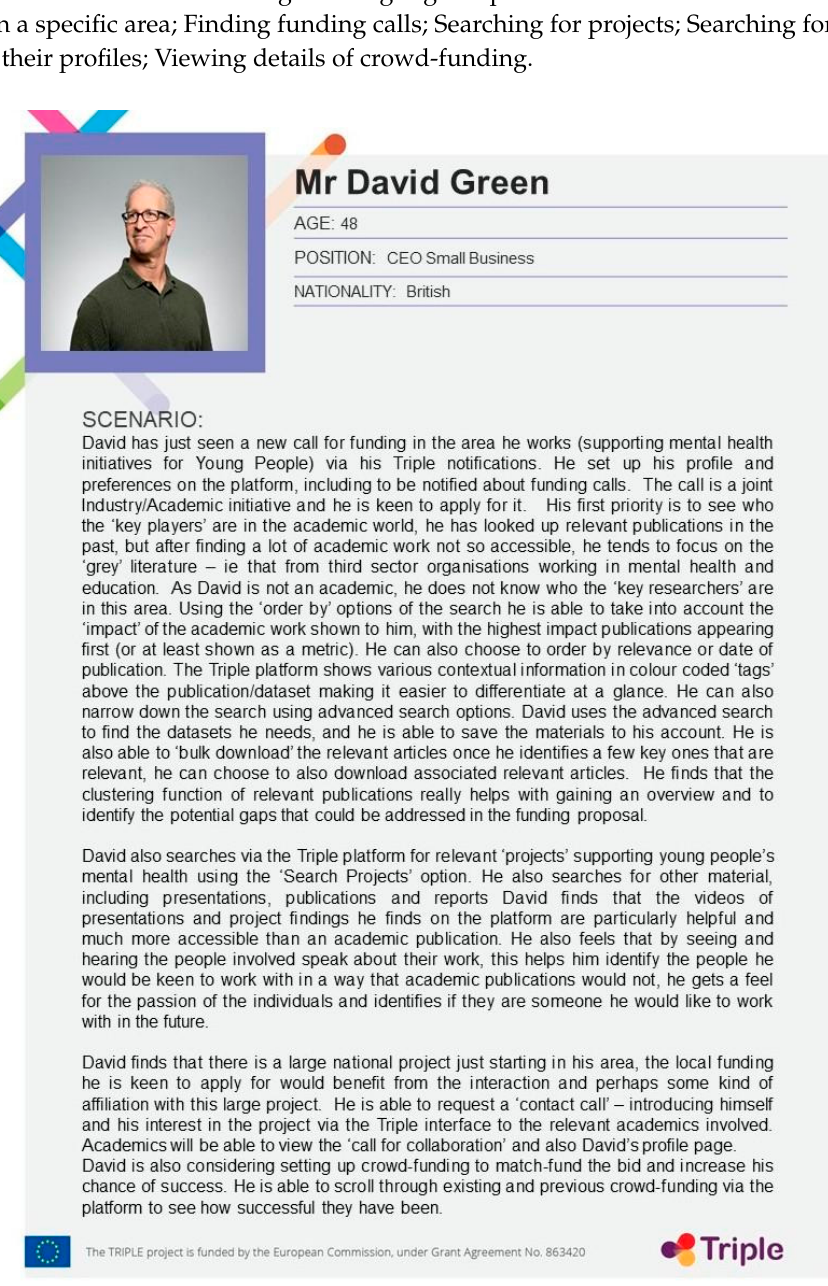
Figure 6. Example of a non-academic scenario created from the results of the requirement analysis.